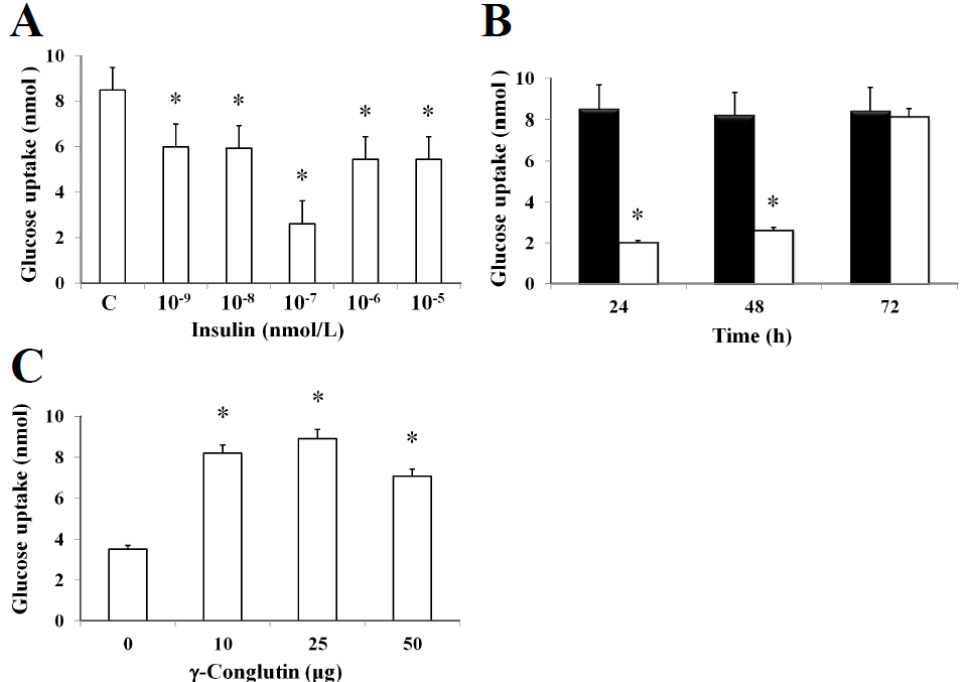
Figure 4. Insulin-resistant IR_PANC-1 cell model and glucose consumption promoted by γ -conglutin. ( A ) Increasing concentrations of insulin from 10 − 9 to 10 − 5 nmol/L showed that cell culture did uptake the lower level of glucose at 10 − 7 nmol/L in comparison to C cell culture, taking this concentration as the level of insulin where cells acquired the resistance state. ( B ) C cells were cultured for 24, 48 and 72 h, testing the glucose uptake of cultures including 10 − 7 nmol/L (white bars), in comparison to control C cells (black bars). In these assays were showed that insulin resistance state is preserved for 48 h. p * ˂ 0.05 IR-C versus C. ( C ) Glucose consumption by IR-C cells promoted by γ -conglutin at 0, 10, 25 and 50 μ g was assayed after 24 h of culture. Values are shown as the mean ± SD from three independent experiments. p < 0.05 represents statistically significant differences associated with each figure. p * < 0.05 treated cells ( μ g) versus control.